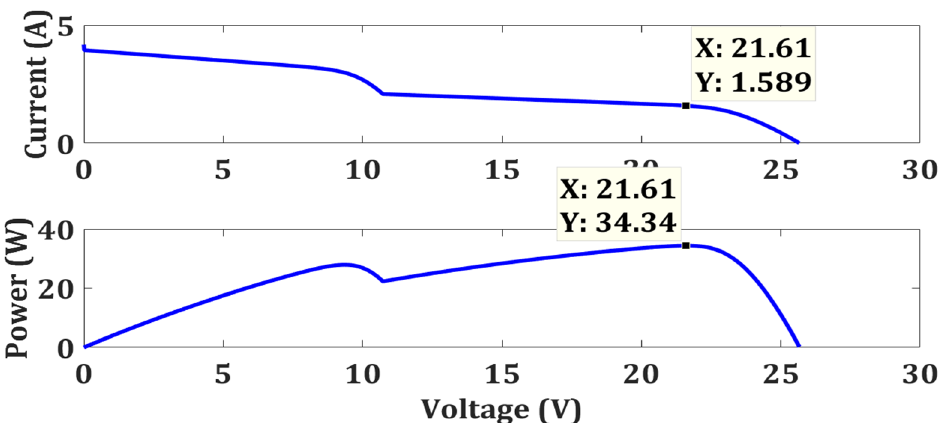
Figure 32. Characteristic curves of 2S PV system for test case 2 .